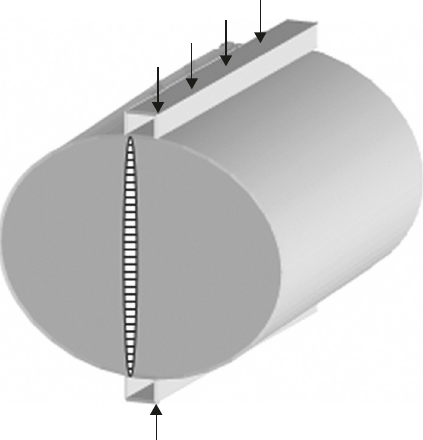
Figure 3: Schematic diagram of the indirect tensile fatigue